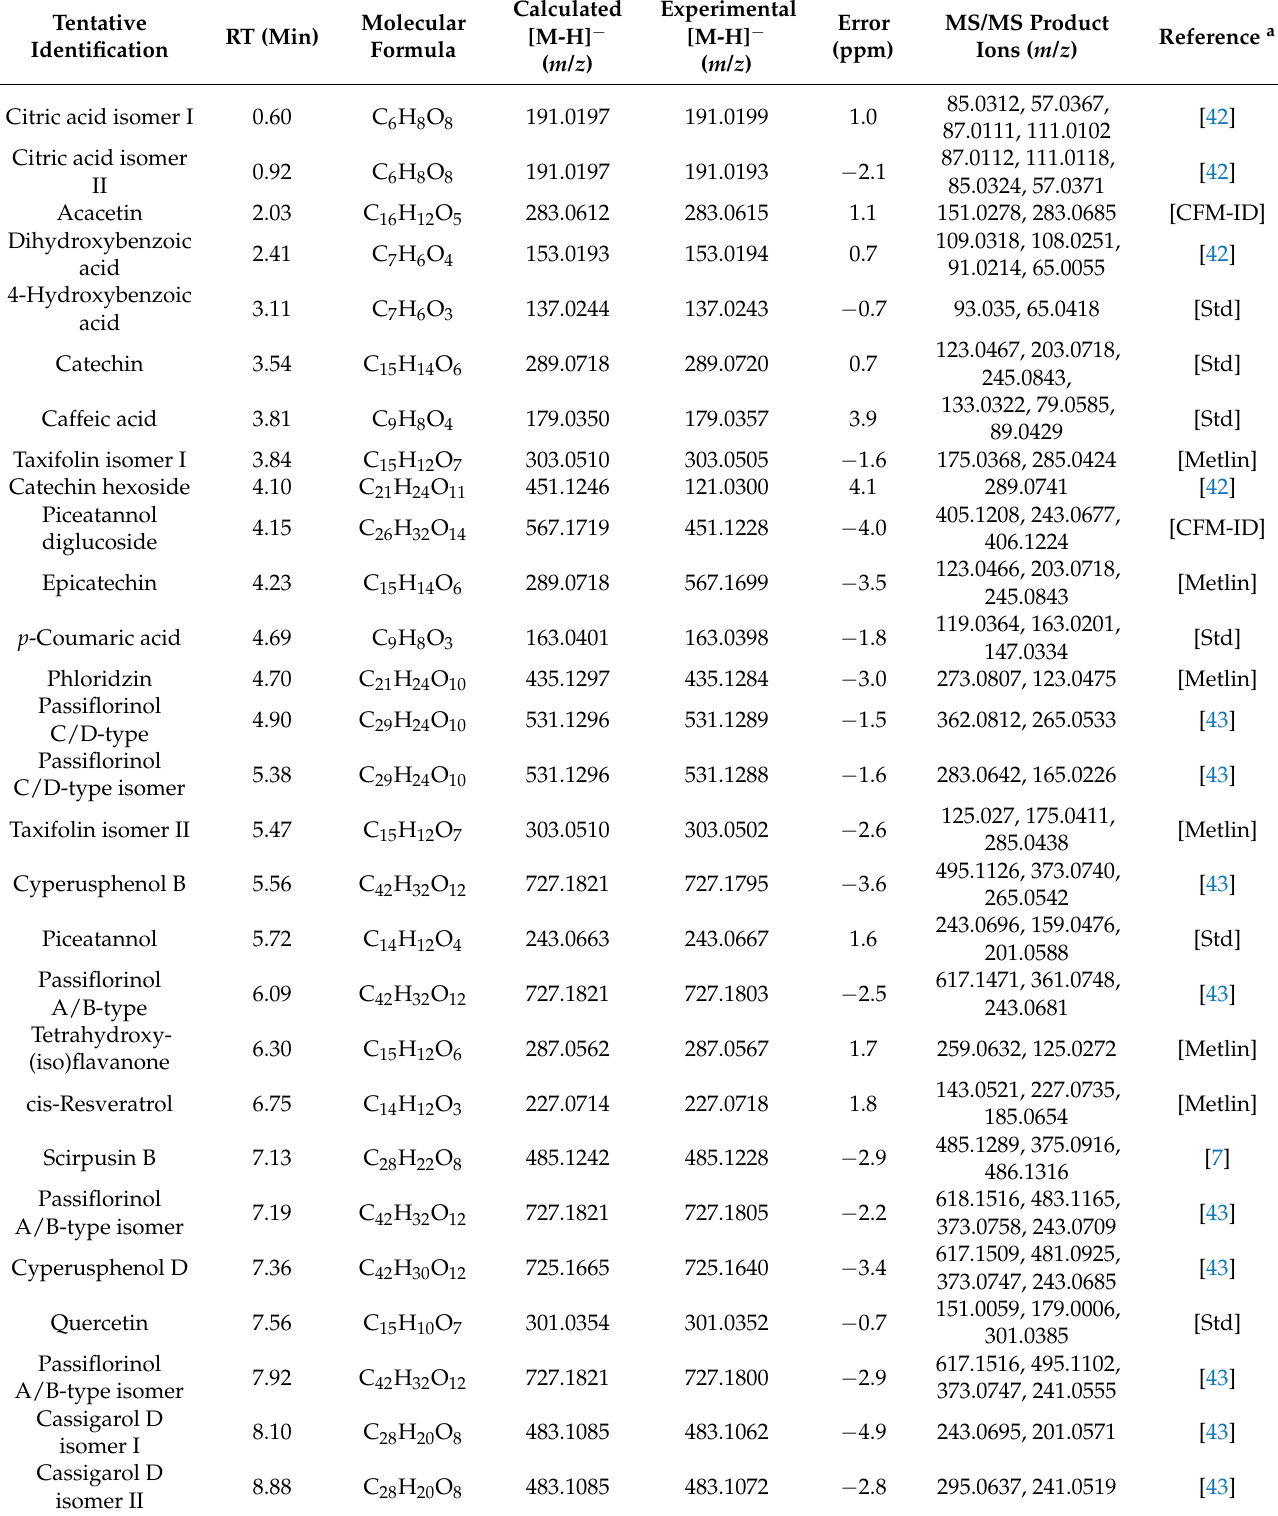
Table 4. Tentatively identified compounds in d-PFBP extract (PLE with EtOH at 110 ◦ C, cycle